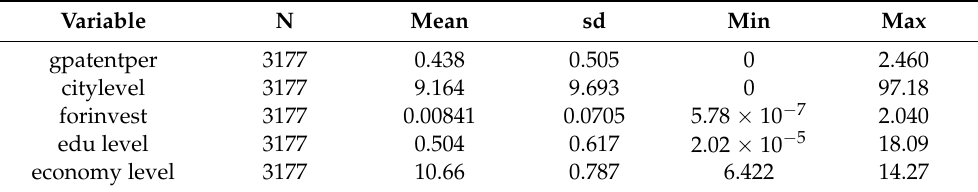
Table 1. Descriptive statistics of the main